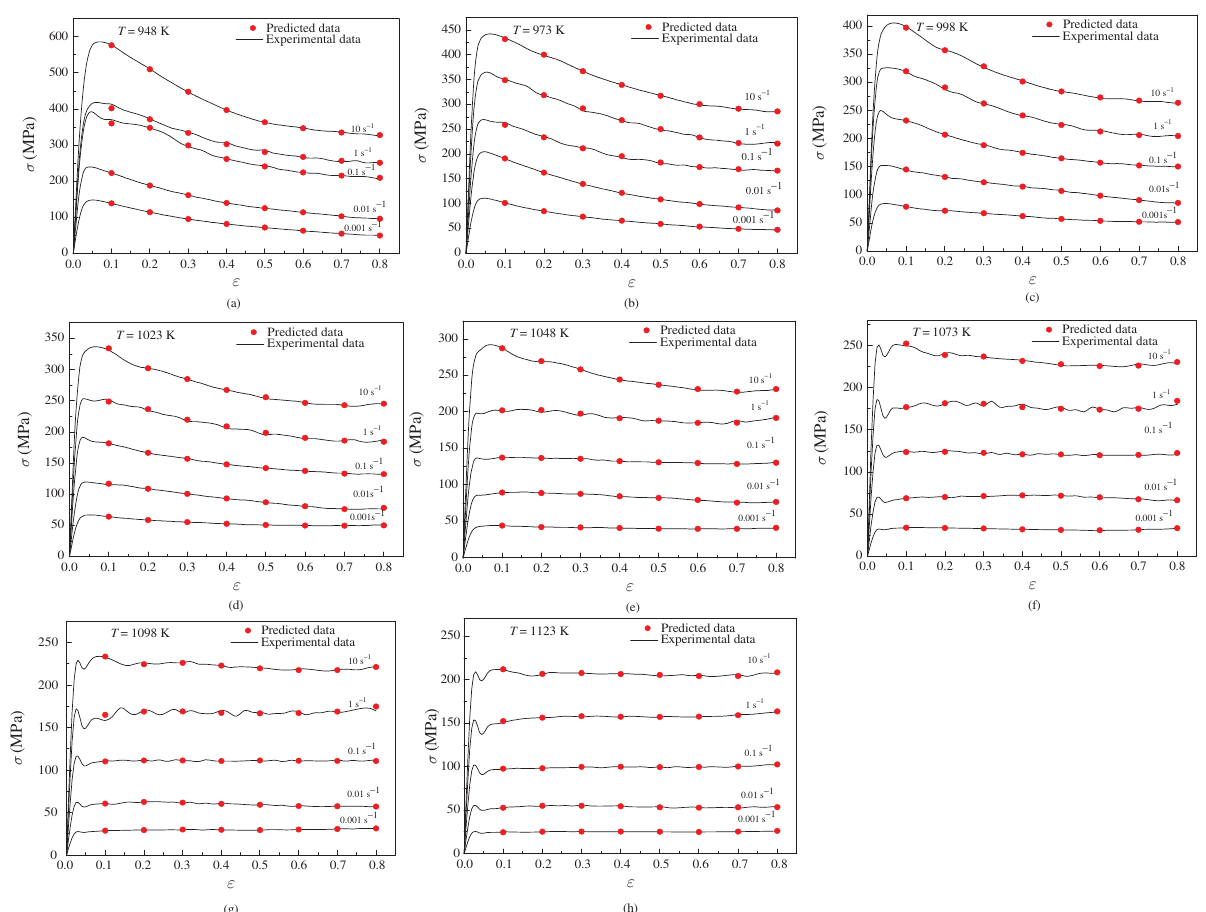
Figure 11 Comparison between the experimental and predicted flow stress by ANN model at different strain rates and temperatures: (a) 948 K, (b) 973 K, (c) 998 K, (d) 1,023 K, (e) 1,048 K, (f) 1,073 K, (g) 1,098 K, (h) 1,123